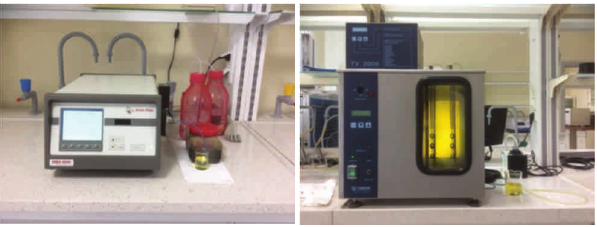
Fig. 3. DMA 4500/5000 for density determination and TV 2000 viscome- ter for determining kinematic viscosity